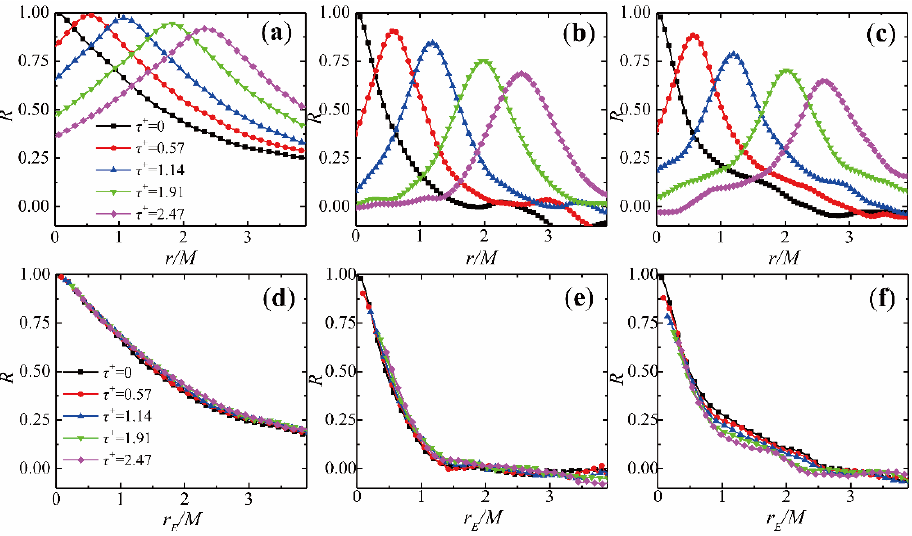
Figure 9. Stream-wise evolution of space-time correlation functions at 5 different time delays for ( a ) base flow; ( b ) x / M = 8; ( c ) x / M = 18 and verification of the elliptic model for ( d ) base flow; ( e ) x / M = 8; ( f ) x / M = 18.